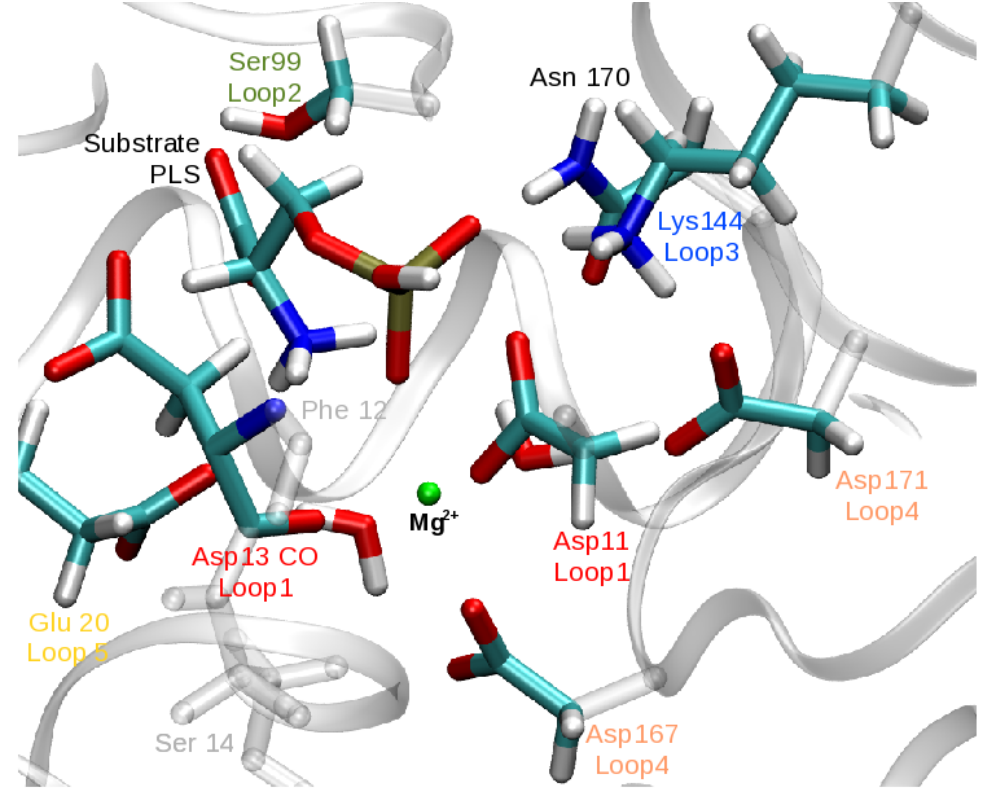
Figure 3. Atoms comprising the larger QM region as described in Section 2.3. The small QM region differs from the large QM region in the exclusion of the atoms of residues Asn170 and